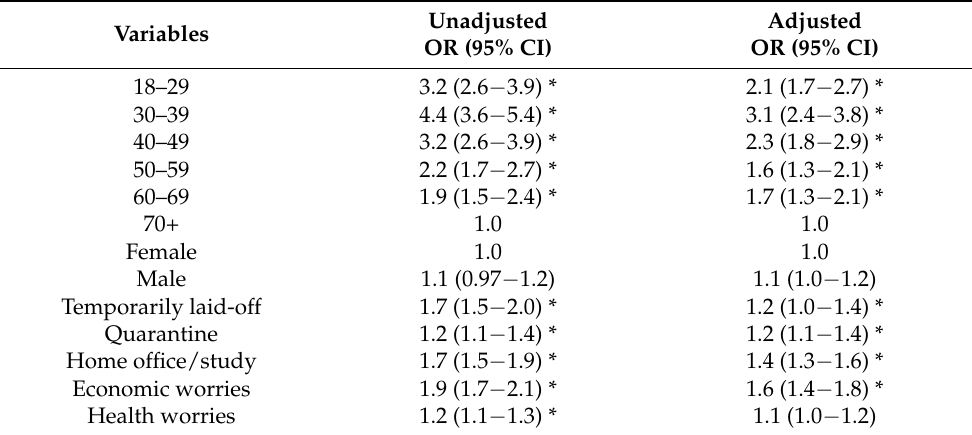
Figure 1. Distribution of binge drinking, hazardous drinking, and increased alcohol consumption in relation to age and worries (inverse probability-weighted estimates). The differences between those worried and those not worried were significant ( p < 0.05 for each of the three outcomes). Table 3. Risk factors for increase in alcohol consumption during COVID-19 pandemic phase assessed with logistic regression utilizing odds ratios and 95% confidence intervals. For the adjusted model, all presented variables were included in the model.